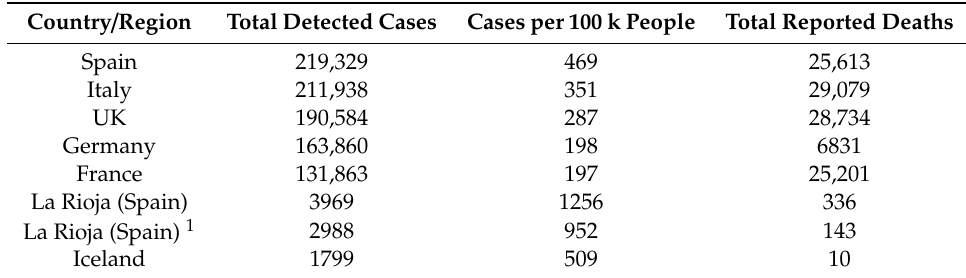
Table 1. Reported COVID-19 cases per country/region (updated 5 May 2020).